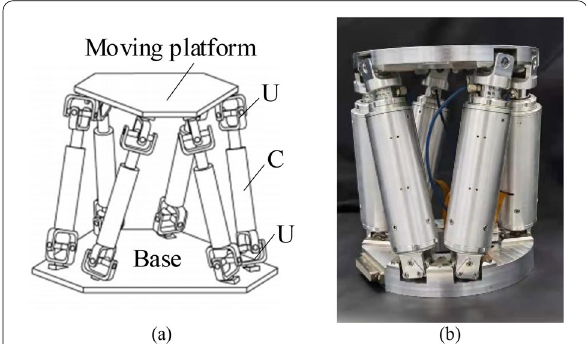
Figure 4 6-UCU bone-attached PM: a 6-UCU parallel mechanism, b Prototype of the 6-UCU bone-attached PM